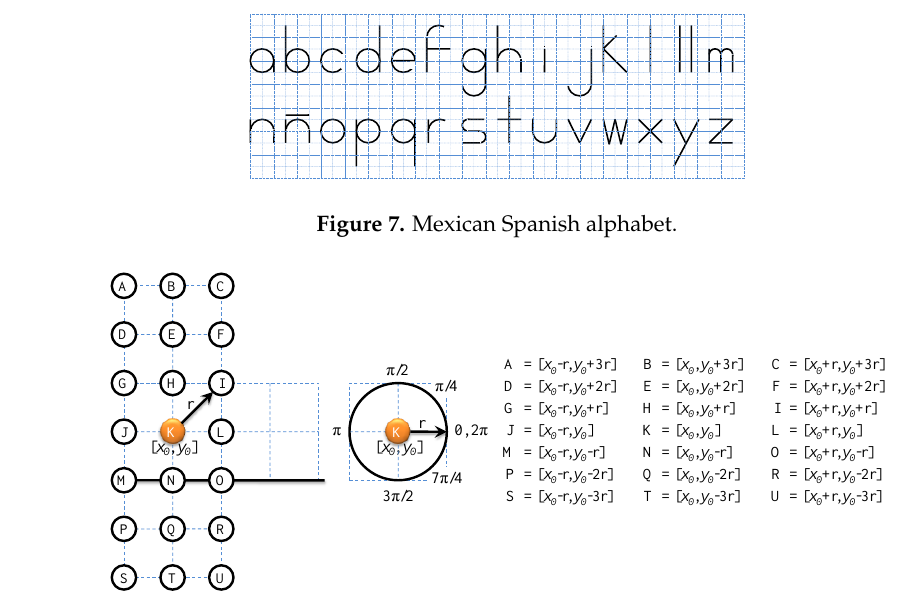
Figure 8. Point-based approach for alphabet drawing